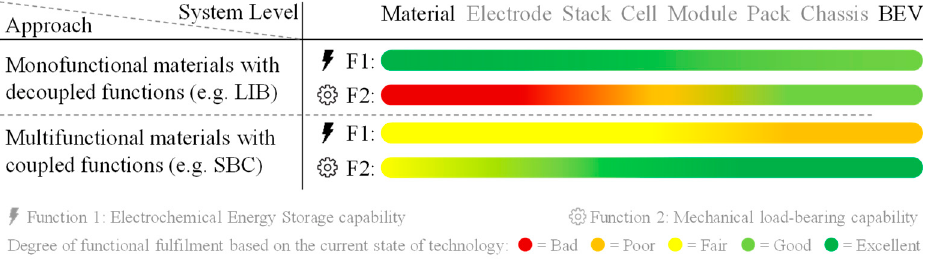
Figure 3. Elementary di ff erences between monofunctional and multifunctional